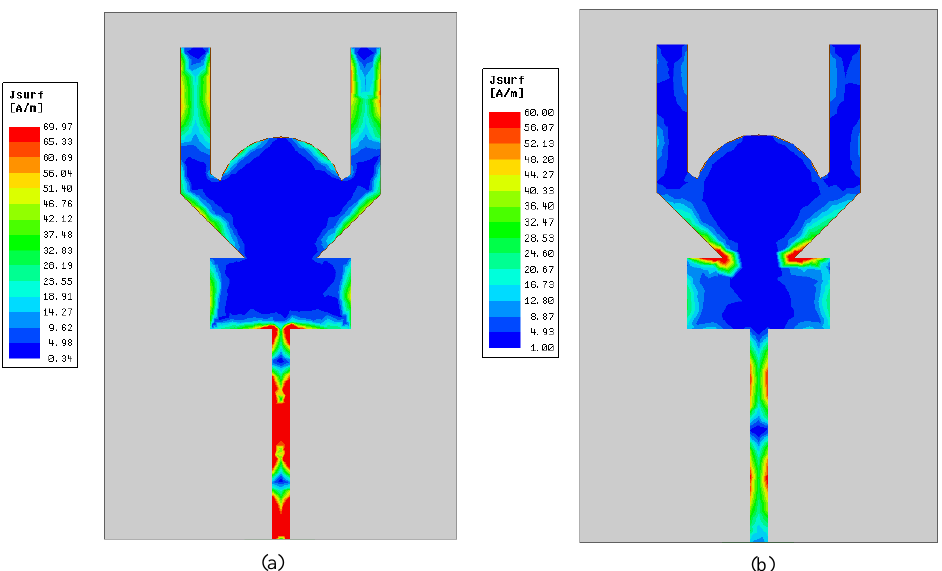
Figure 8. Surface current distribution of the proposed single element of antenna ( a ) 28 GHz and ( b ) 38 GHz.